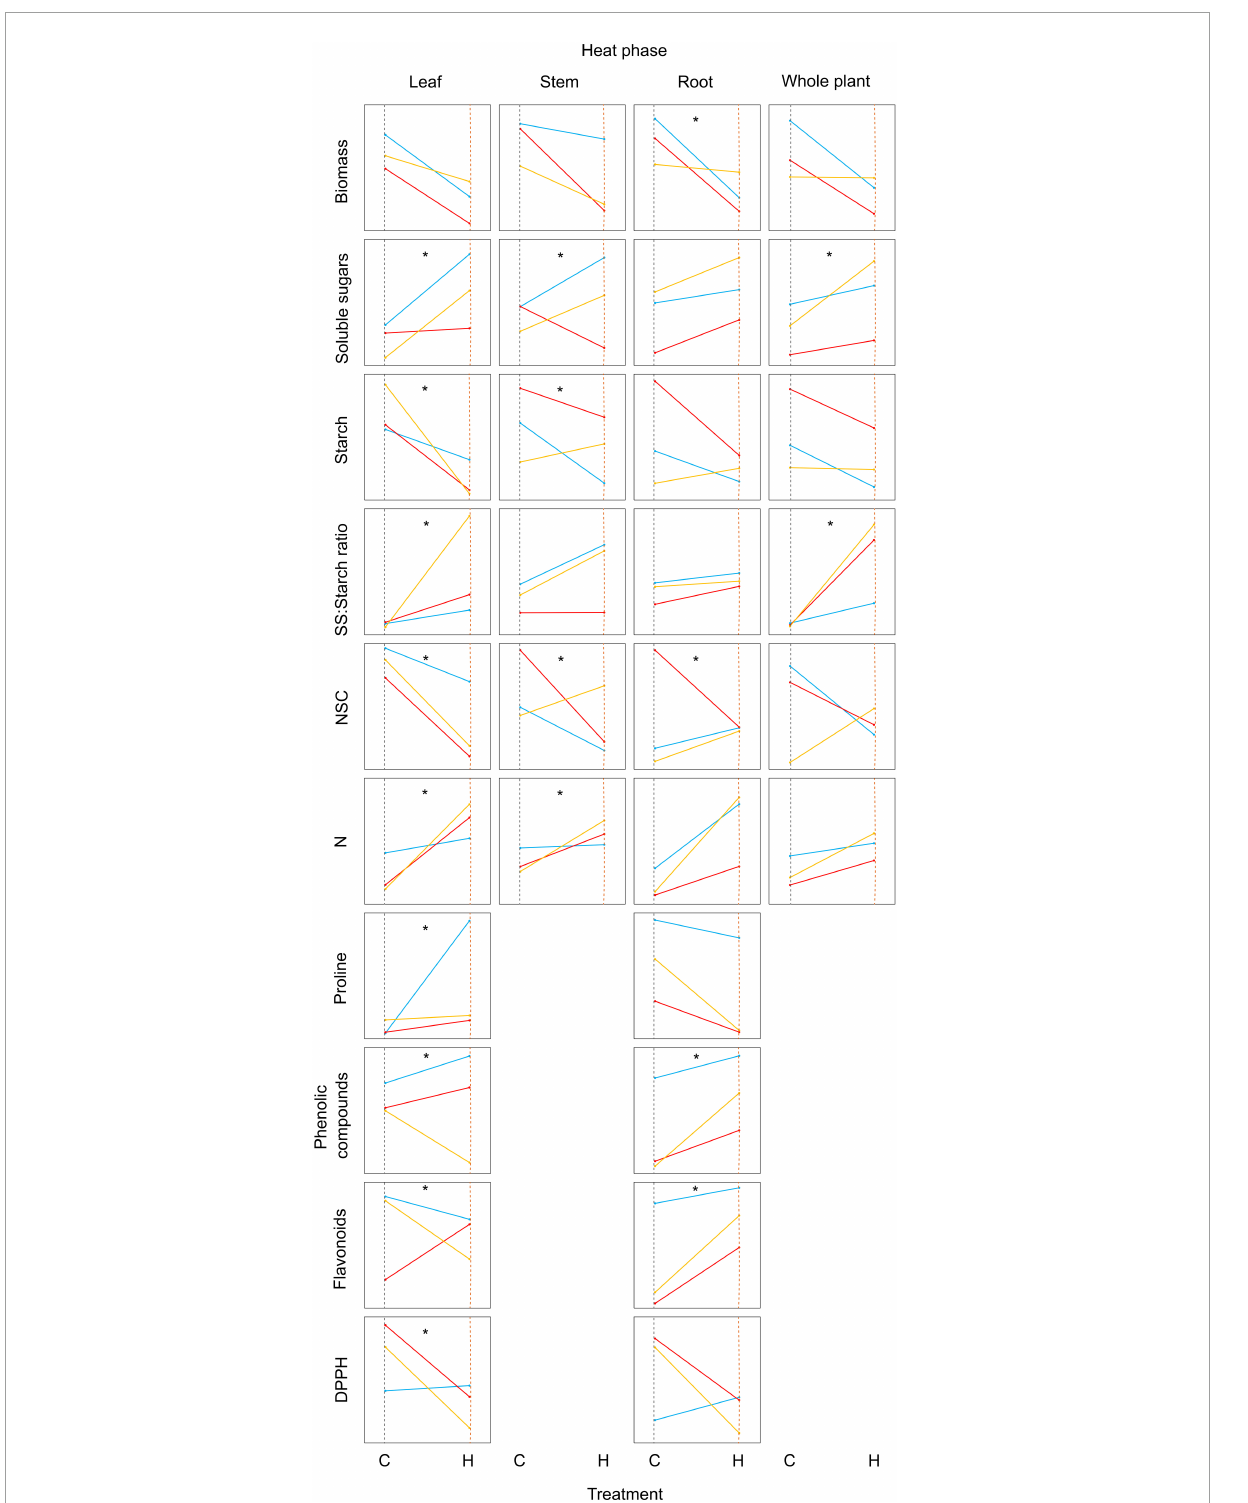
FIGURE8 Phenotypic values of ten physiological and biochemical parameters obtained from the leaf, stem, fine root, and whole plant of Castanea sativa seedlings from the northern (blue line), central (red line), and southern (yellow line) populations in Spain after seedlings were subjected to ambient temperature (C) and heat stress (H) treatments for 7 days. Asterisks indicate significant population × treatment interactions, and provide evidence for genetic variation in phenotypic plasticity of parameters in response to heat stress.